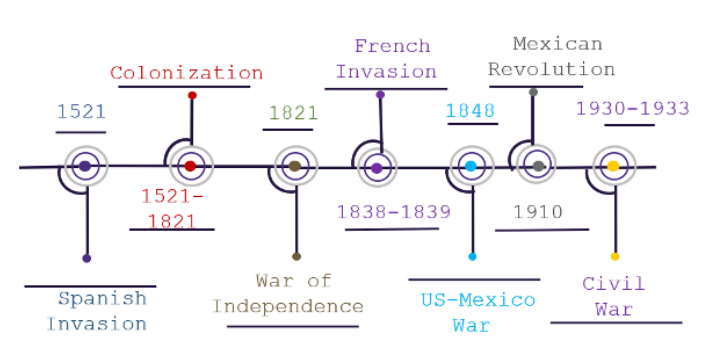
Figure 1. Timeline of Historical Trauma